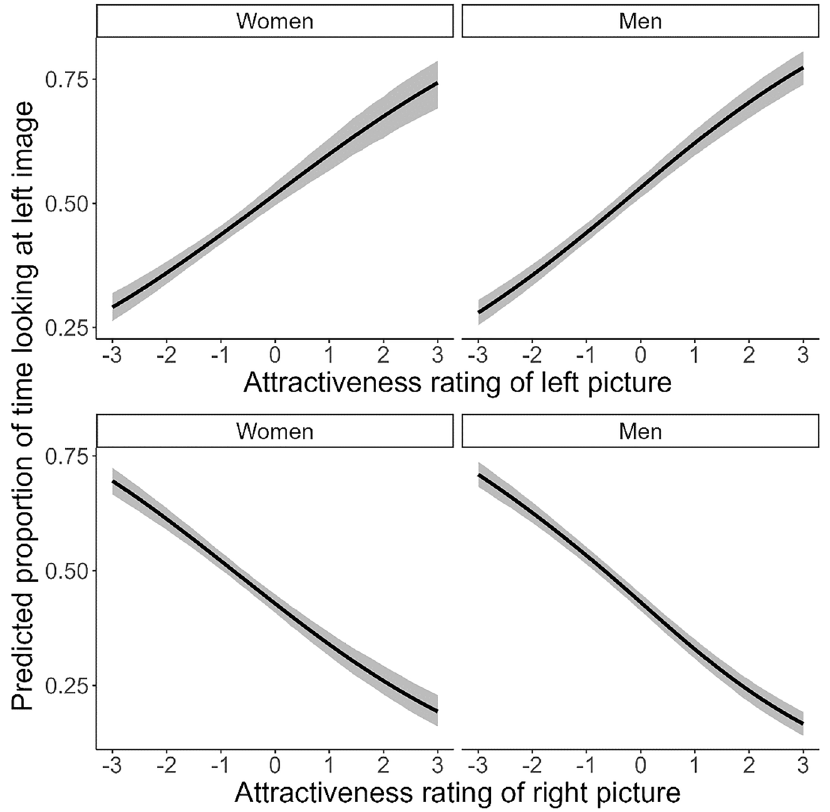
Figure 3. Effect plot showing associations between Pre‑date attractiveness rating and Looking time bias separate per Gender . The black line represents the median effect, while the grey ribbon represents the 95% credible